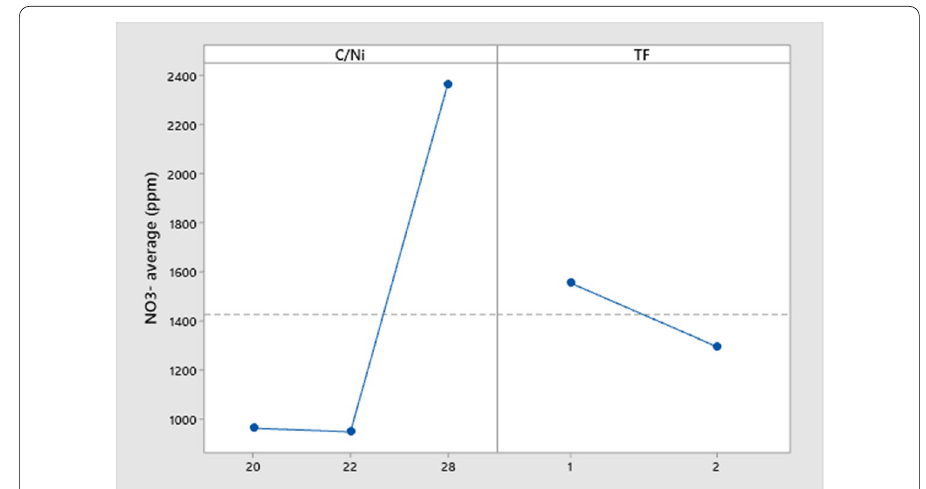
Fig. 5 Effect diagram of C/Ni and TF on NO3